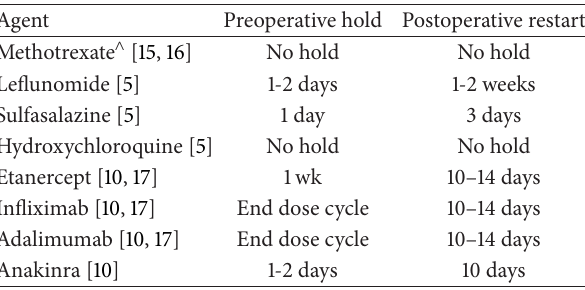
Table 1: Disease-modifying antirheumatic drugs (DMARDs) dos- ing regimen in the perioperative period. The preoperative withhold- ing period prior to surgery is specified as well as the waiting period postoperatively prior to reinstituting the